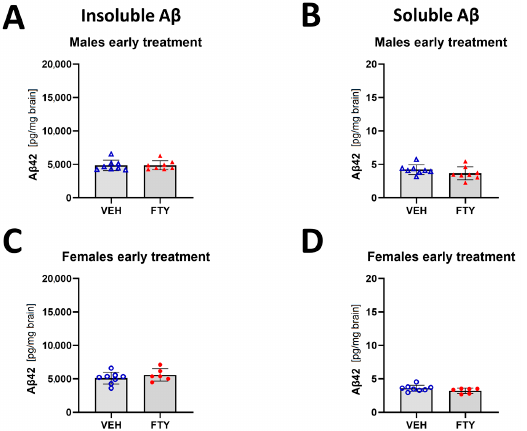
Figure 3. Quantification of insoluble ( A , C ) and soluble ( B , D ) A β 42 for early treated males ( A , B ) and females ( C , D ). Data are presented as mean ± SD; n = 8 (except for FTY treatment females, n = 6). Significance was calculated using Wilcoxon–Mann–Whitney test.